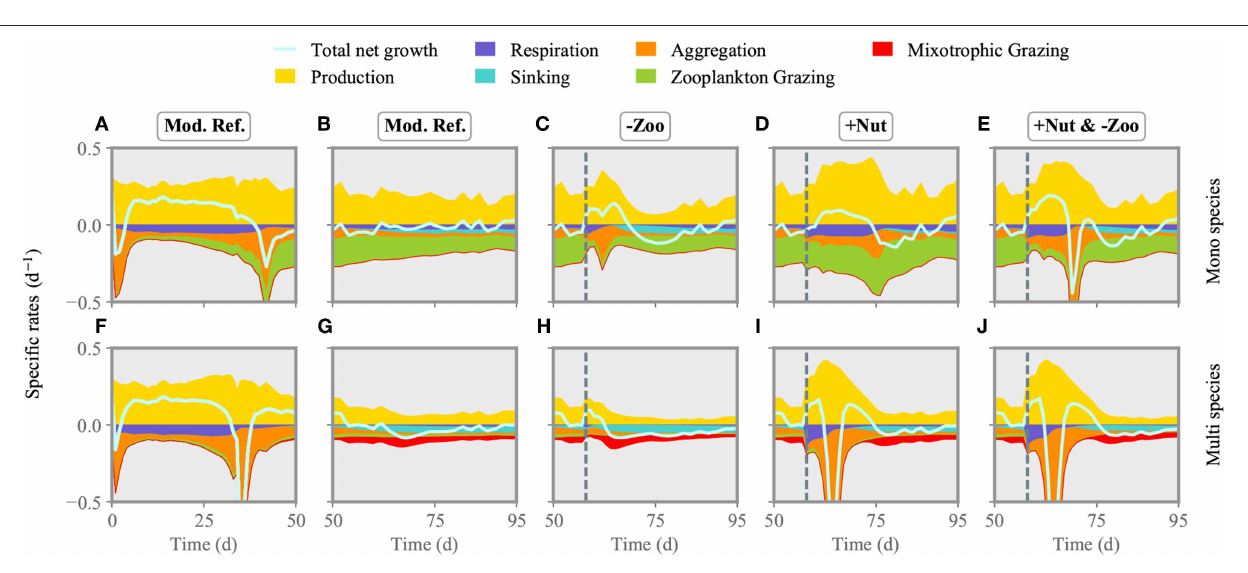
FIGURE 4 | Comparison of phytoplankton production and loss terms between the mono species model (A–E) and the one with multi species (F–J) . The reference run is shown for the first (A,F) and second half of the experiment (B,G) . The two single/multiple stressors grazer removal (-Zoo, C,I ) and nutrient enrichment ( + Nut, D,H ) are combined in the multiple stressor experiment (E,J) . The solid line shows relative growth rate (production-losses) of the entire community. The dashed line indicates the time of stressor